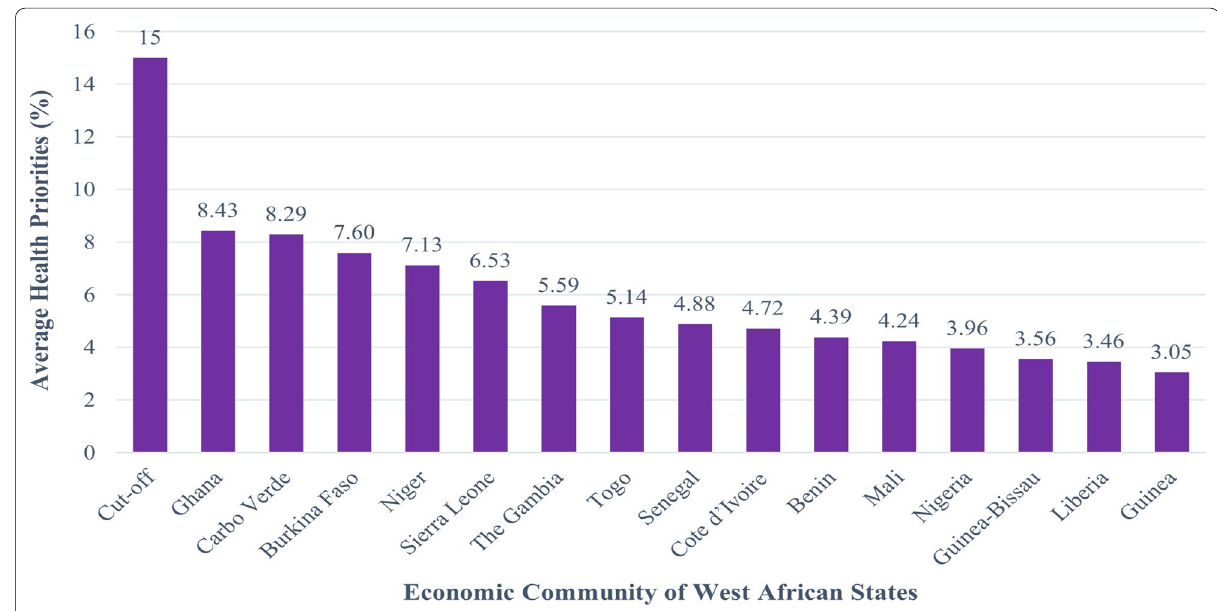
Fig. 2 Plot of the average health priorities in the Economic Community of West African States including cutoff point of at least